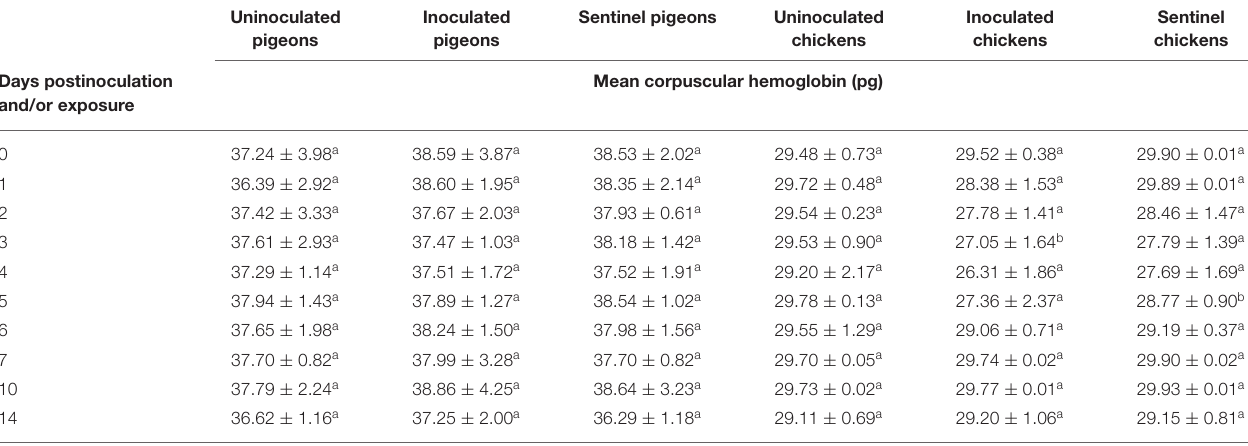
TABLE 2 | Mean corpuscular hemoglobin of pigeons and chickens following inoculation with and/or exposure to a very virulent infectious bursal disease virus.